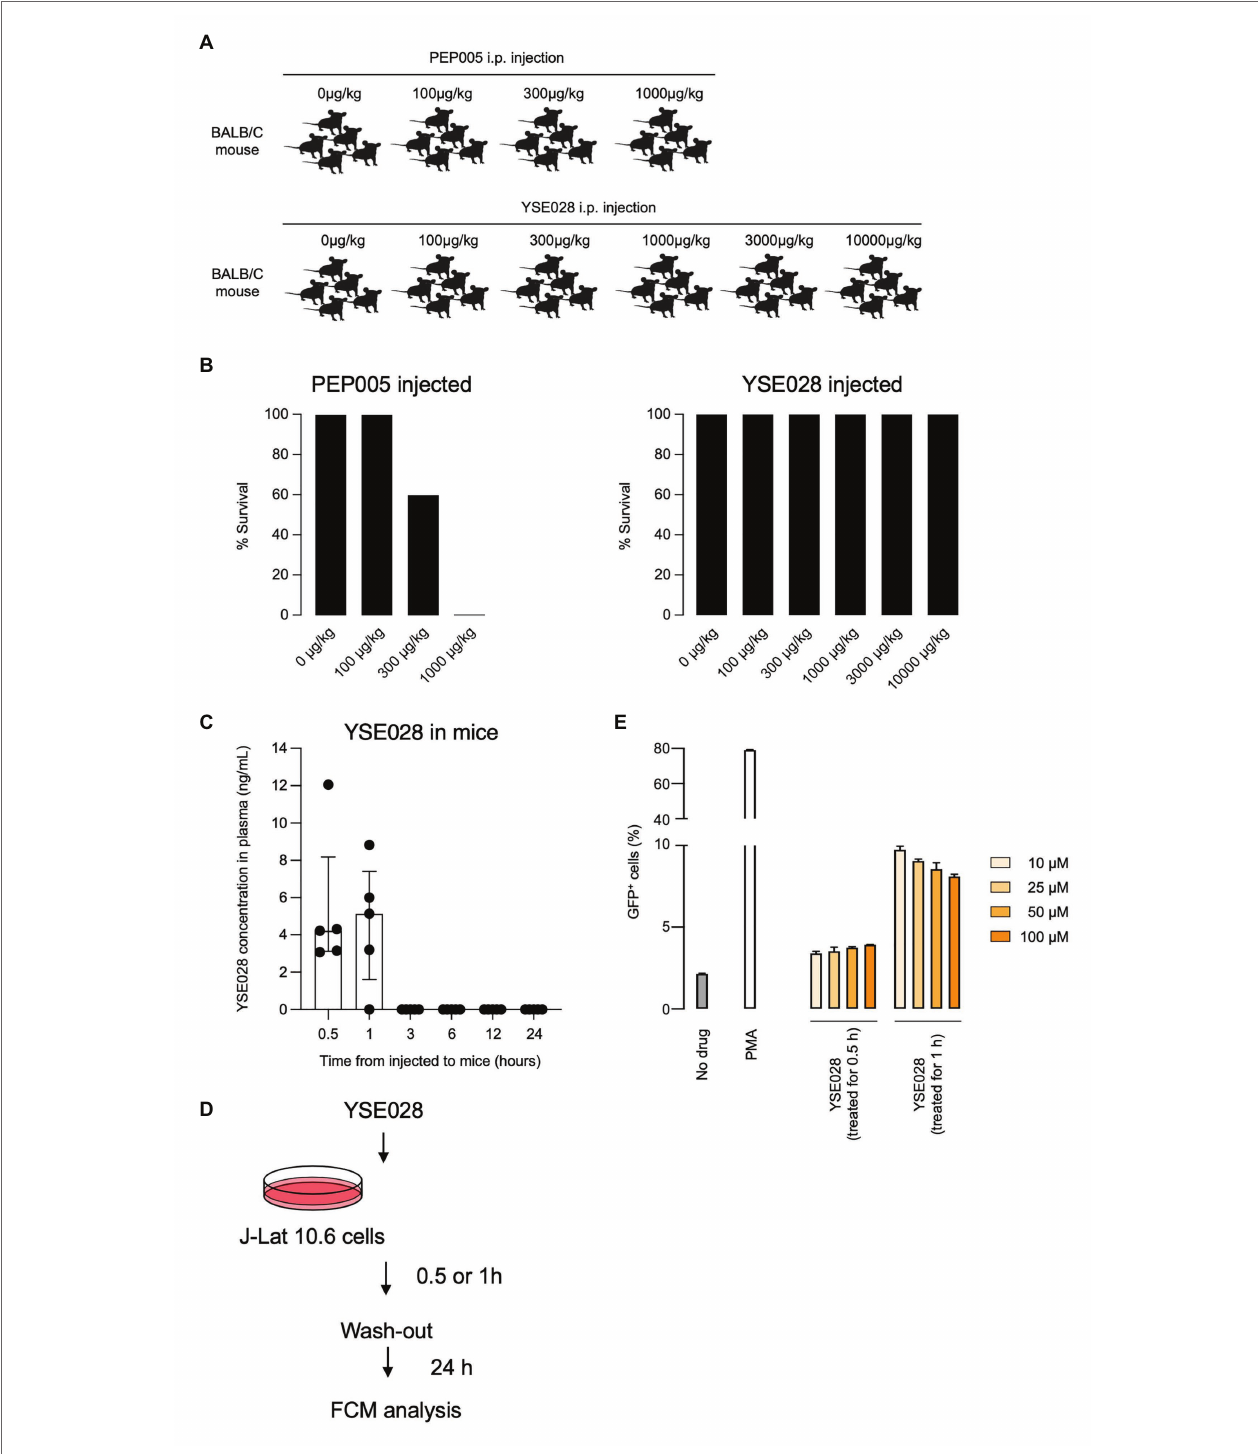
FIGURE 6 | In vivo toxicity and pharmacokinetic analyses of YSE028. (A) The experimental scheme is illustrated. BALB/c mice were challenged with increasing concentrations of PEP005 or YSE028 by intraperitoneal injection, with five animals in each group. (B) The survival rate of PEP005- and YSE028-injected mice. (C) Plasma concentration of YSE028 in BALB/c mice. The concentrations were measured by LC-MS/MS at 0.5, 1, 3, 6, 12, and 24 h after administration of YSE028 at a dose of 10 mg/kg. Data are shown as medians with interquartile ranges, n = 5. (D) The experimental scheme for short-term exposure to YSE028. (E) J-Lat 10.6 cells were exposed to YSE028 for 0.5 or 1 h, and then reagent was washed-out. The number of GFP-positive cells was analyzed after 24 h by flow cytometry. Data are shown as means ± SDs of three independent